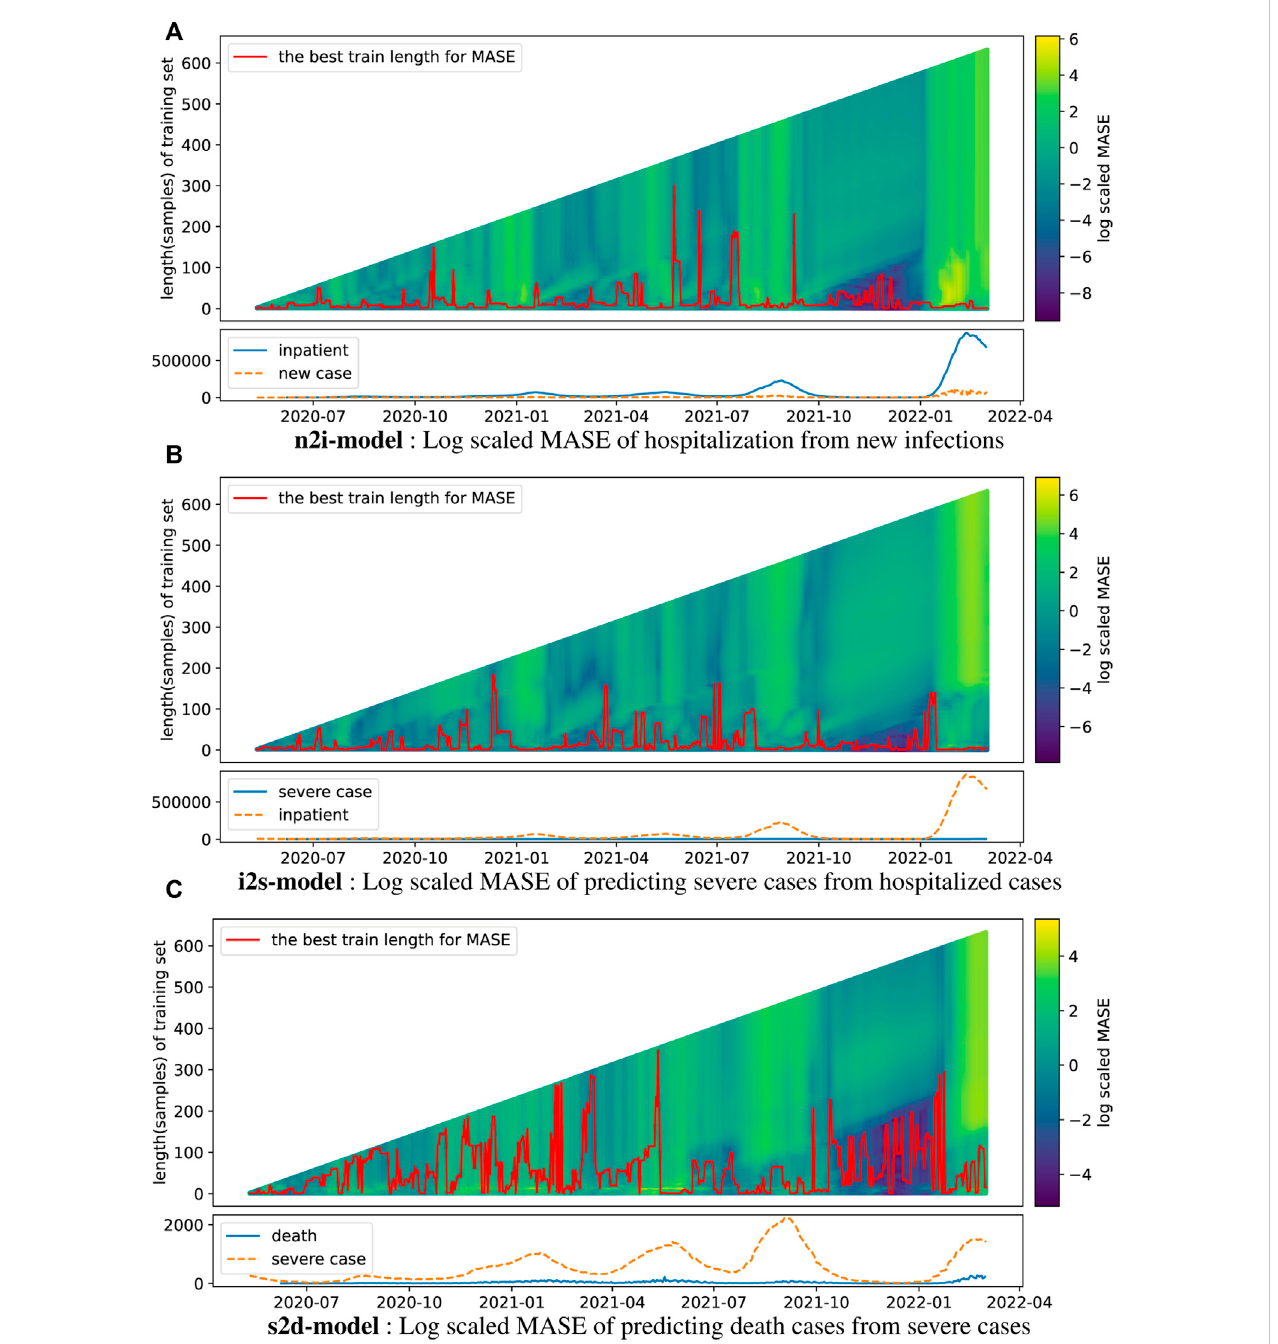
FIGURE 8 MASEs of COVID-19. (A) n2i-model: Log scaled MASE of hospitalization from new infections. (B) i2s-model: Log scaled MASE of predicting severe cases from hospitalized cases. (C) s2d-model: Log scaled MASE of predicting death cases from severe cases.